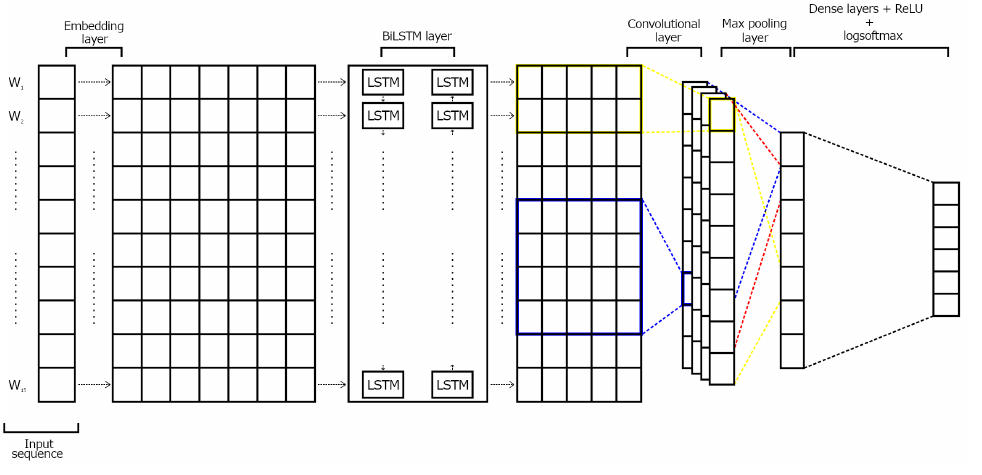
Figure 1. BiLSTM + CNN for text classification.